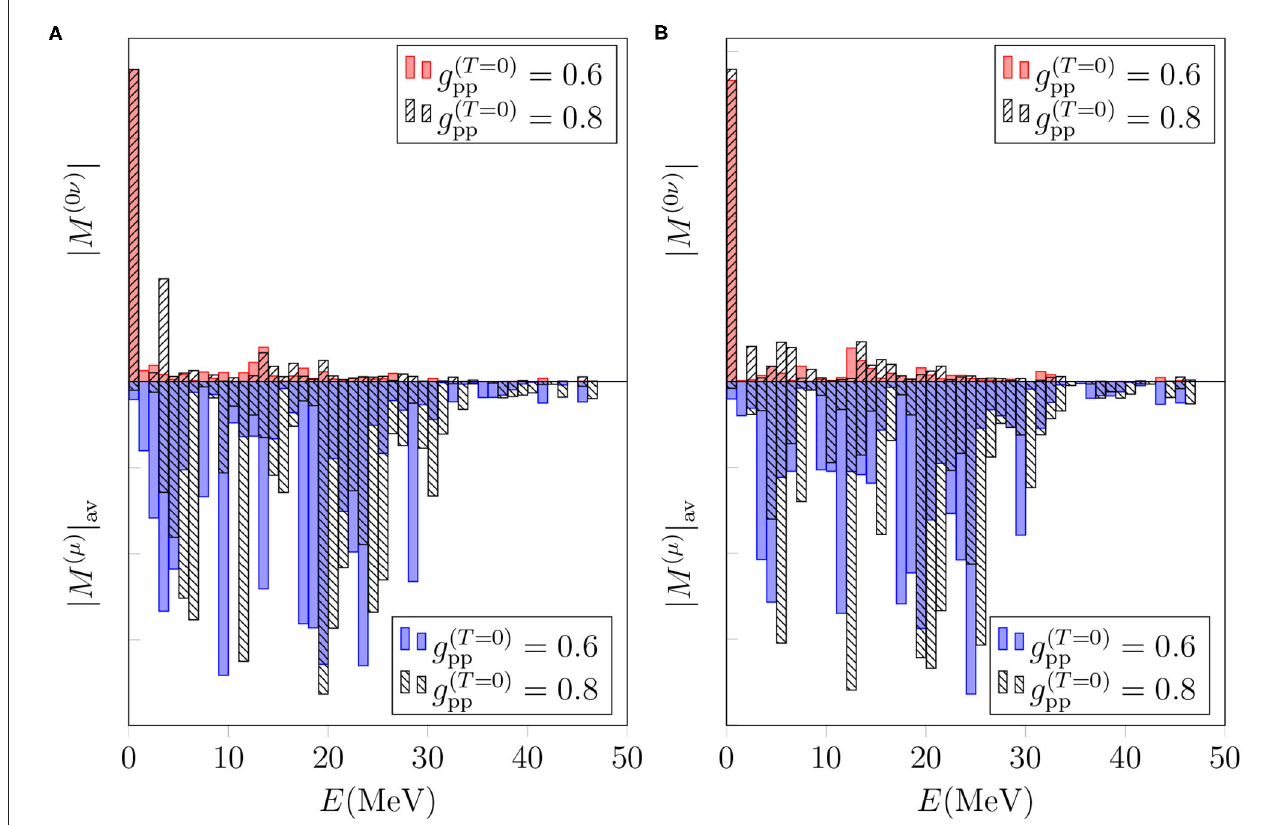
FIGURE 7 | Dependence of the energy distributions of the 0 νβ + β + -decay and OMC matrix elements for the J π = 1 + multipole on the particle-particle parameter g ( T = 0) pp in different bases. The OMC matrix elements are computed assuming the exact Dirac wave functions for a finite nucleus with uniform charge distribution. (A) Basis: “Adj.”. (B) Basis: